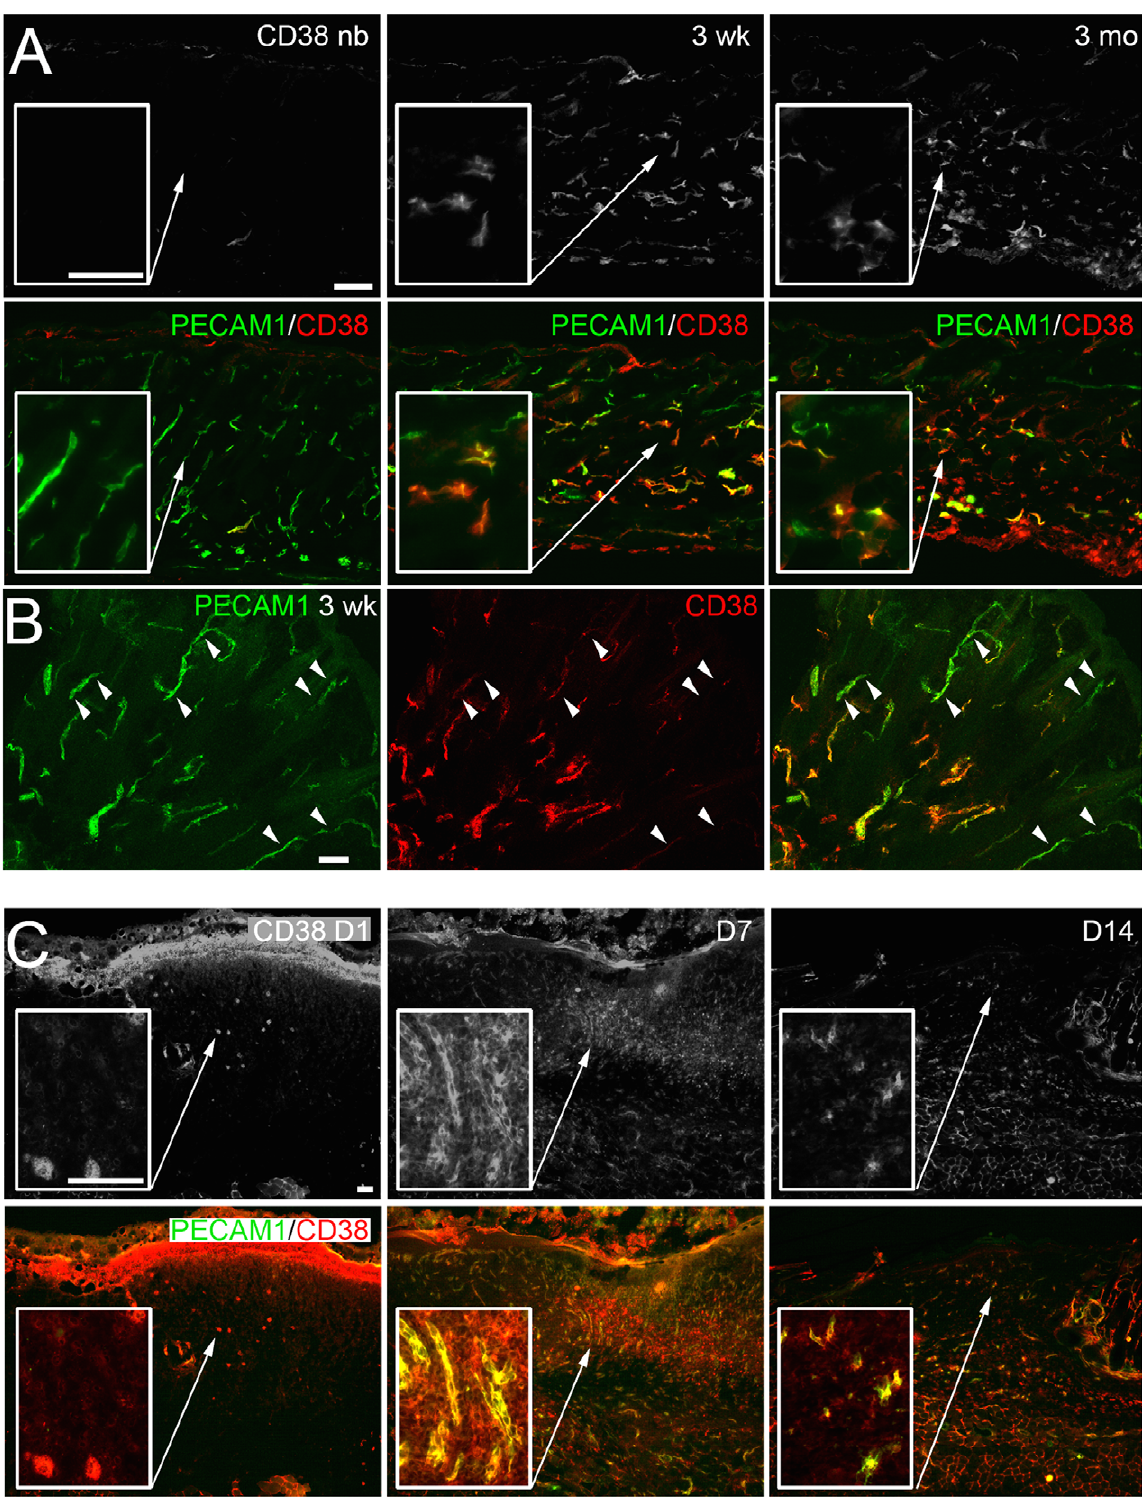
Figure 4. Insitu detection of the CD38 receptor in the maturing skin and wound. (A) Expression of PECAM1 and CD38 in cryosections of newborn (nb), three weeks (3 wk) and three months (3 mo) old skin was detected by immunofluorescence microscopy. The fluorescence signal for CD38 (top row) and the overlay with PECAM1 is shown. (B) Confocal microscopy analysis of PECAM1/CD38 expression in three weeks old skin. PECAM1 + vessels lacking CD38 expression are indicated (arrowheads). (C) Localization of PECAM1 and CD38 expression in cryosections of wounds one (D1), seven (D7) and 14 days (D14) post injury. The fluorescence signal for CD38 (top row), the overlay with PECAM1 and higher magnifications of the wounded area are shown (A, C, squares). Bars 100 m m (A, C), 50 m m (B).